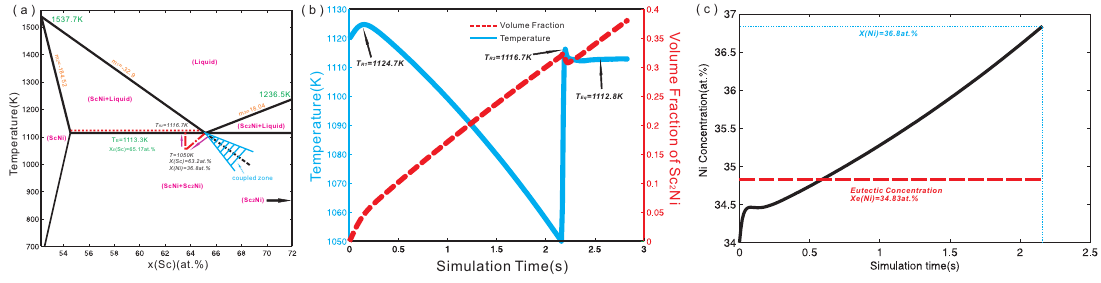
Figure 2. ( a ) Linearized phase diagram of Sc-Ni binary alloy from 52.27 at % Sc to 72 at % Sc constructed according to the recent thermodynamic assessment by Cao et al. [25]; ( b ) Temporal temperature curve (solid-line) and the volume fraction profile (dash-line) during simulation; ( c ) Ni concentration evolution near the Sc 2 Ni